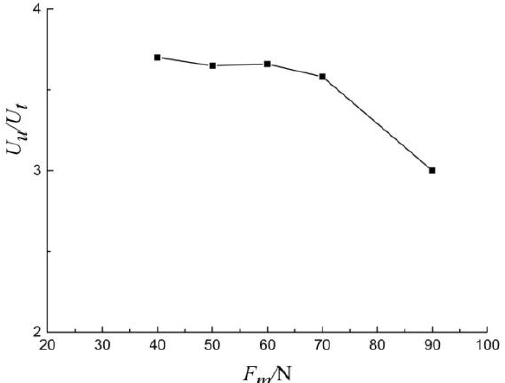
Figure 13. U u / U t versus F m generated with the Berkovich indenter.